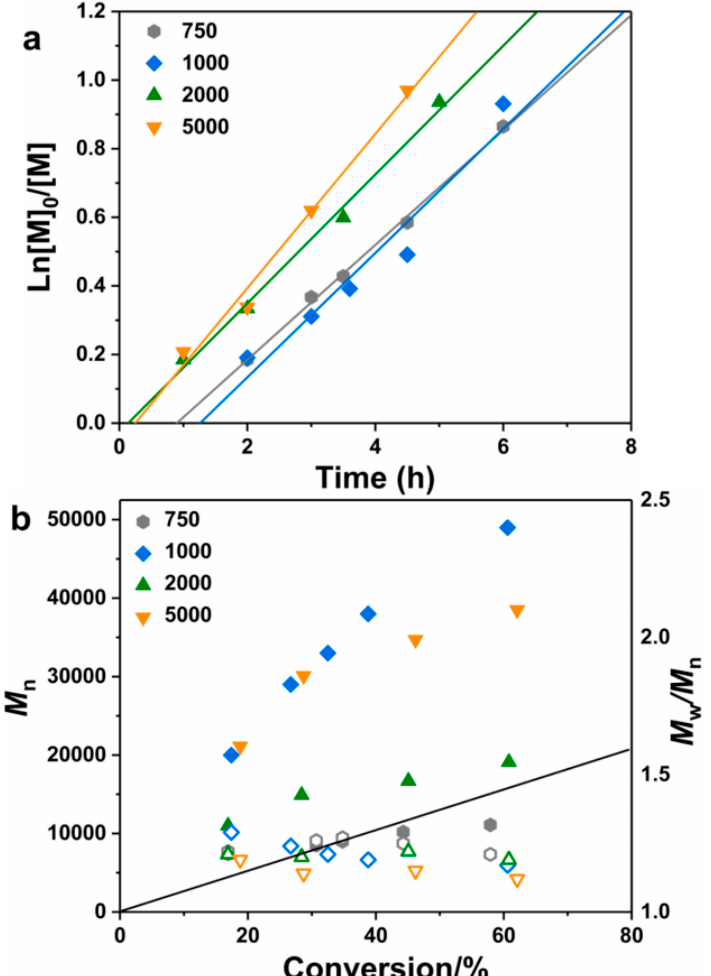
Figure 1. First-order plots ( a ) and evolution of M n and Đ with conversion ( b ) for the bulk FeBr 2 - Figure1. First-orderplots( a )andevolutionof M n and Đ withconversion( b )forthebulkFeBr 2 -catalyzed catalyzed methyl methacrylate (MMA) polymerization in the presence of PEO-Br with different methyl methacrylate (MMA) polymerization in the presence of PEO-Br with di ff erent molecular weights molecular weights (PEO 750 -Br, PEO 1000 -Br, PEO 2000 -Br and PEO 5000 -Br). [MMA] : [FeBr 2 ] : [PEO-Br] = (PEO 750 -Br, PEO 1000 -Br, PEO 2000 -Br and PEO 5000 -Br). [MMA]:[FeBr 2 ]:[PEO-Br] = 200:1:1, T = 60 ◦ 200 : 1 : 1, T = 60 °C.